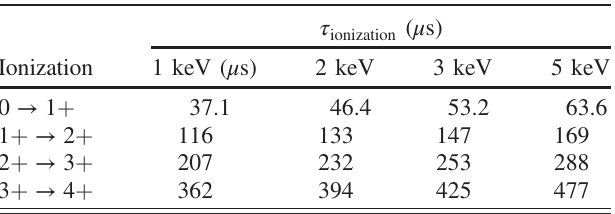
TABLE V. Calculated ionization times [39] inside the plasmoid for Sodium charge states from 0 to 3 þ considering different electron temperatures.